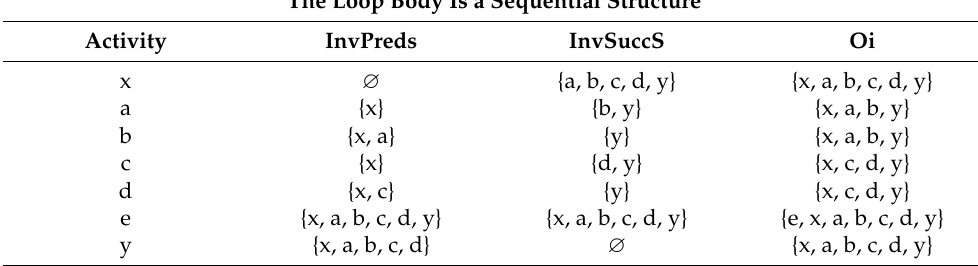
Figure 12. Loop substructure with a concurrent structure. Table 10. Invariant set of activities in Figure 12. The Loop Body Is a Sequential